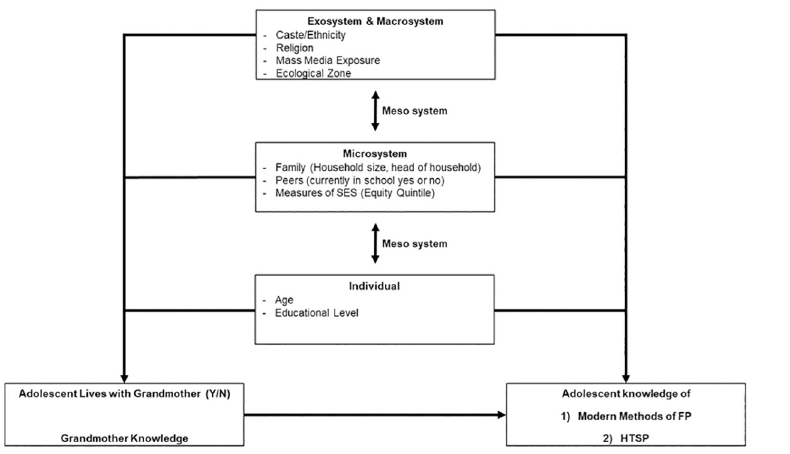
Fig 2. Conceptual framework based on Bronfenbrenner’s Ecological Systems